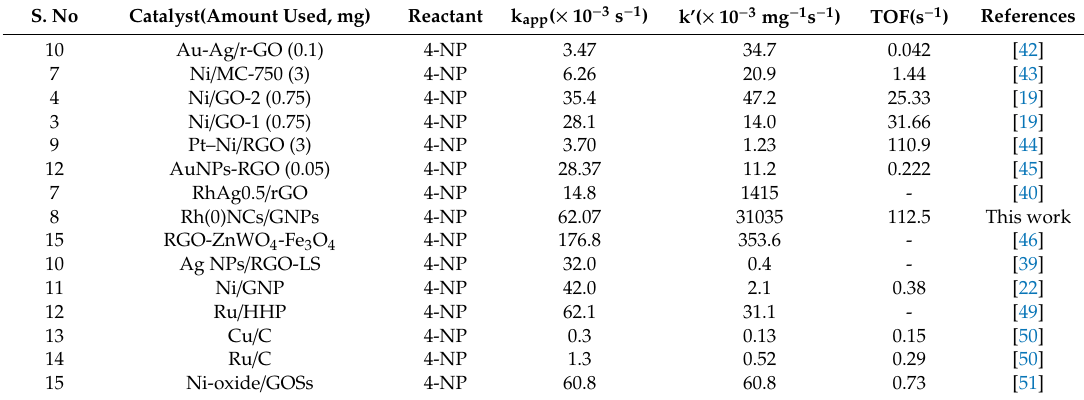
Table 1. Of present Rh(0)NCs / GNPs over other heterogeneous catalysts. S.